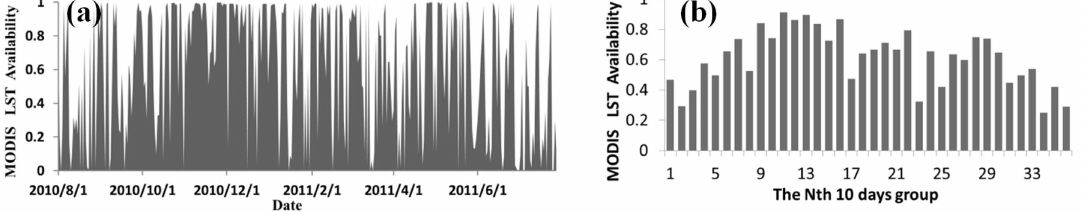
Figure 2. MODIS LST availability in the study area: ( a ) Daily availability (from 1 August 2010 to